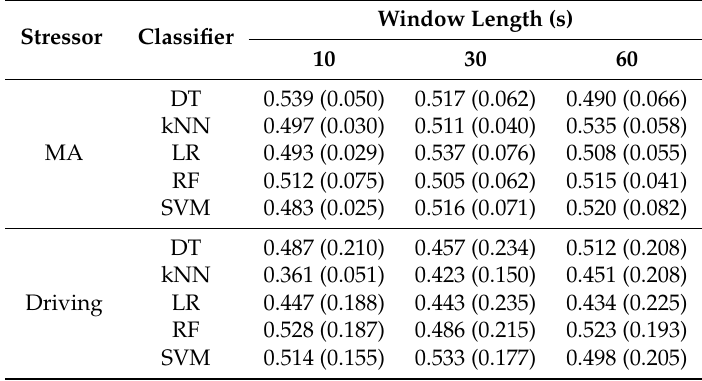
Table 5. Accuracy of the conventional methods. (DT; Decision Tree, kNN; k-Nearest Neighbors,